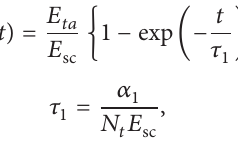
Figure 3: Distributions of 𝑇 for various PSMI conditions. (a) 𝑇 bd for PSMI without interval. Closed circles show the 𝑇 distribution for 𝑄 of 6 C/cm 2 . Open circles show the 𝑇 stress for multiple PSMI experiments with the interval of a